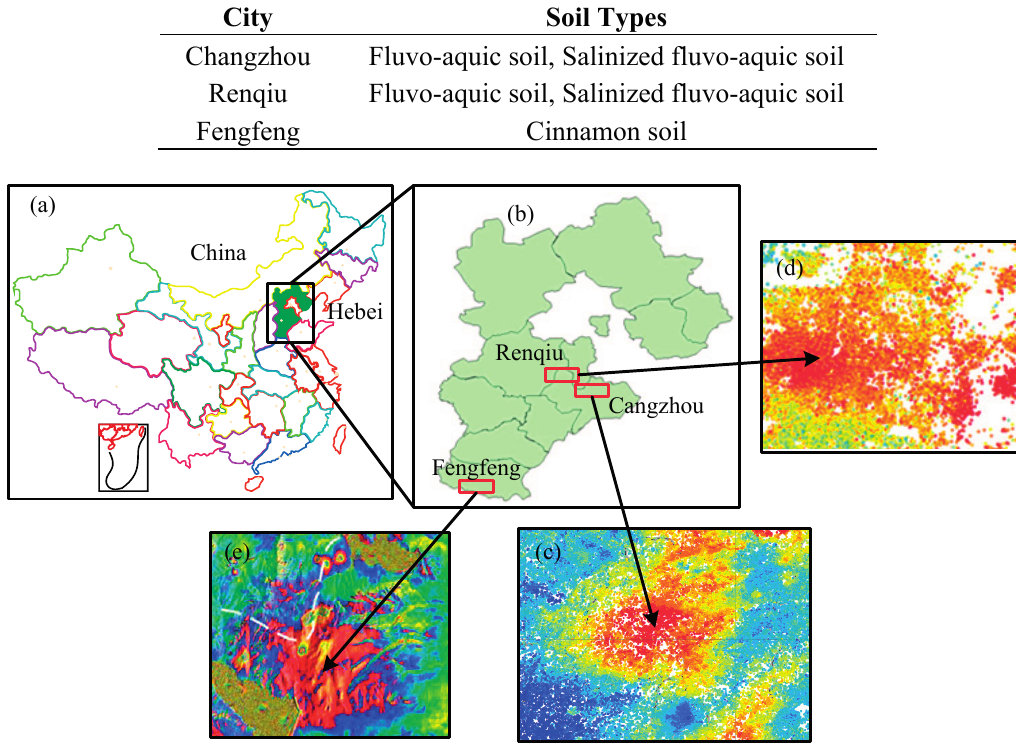
Figure 2. ( a ) Vicinity map of Hebei Province, China; ( b ) Vicinity map of the Changzhou, Fengfeng, and Renqiu study sites within Hebei; Soil sample collection sites from subsided land (red regions) of Changzhou ( c ); Renqiu ( d ) and Fengfeng ( e